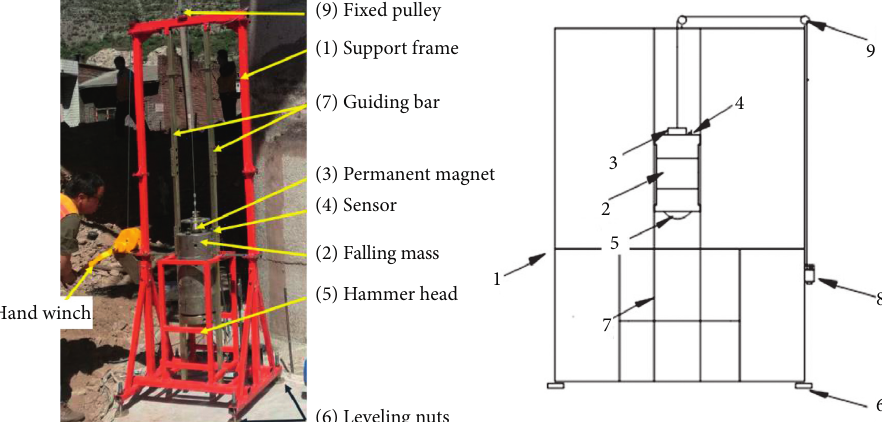
Figure 6: Sketch of the drop weight setup.